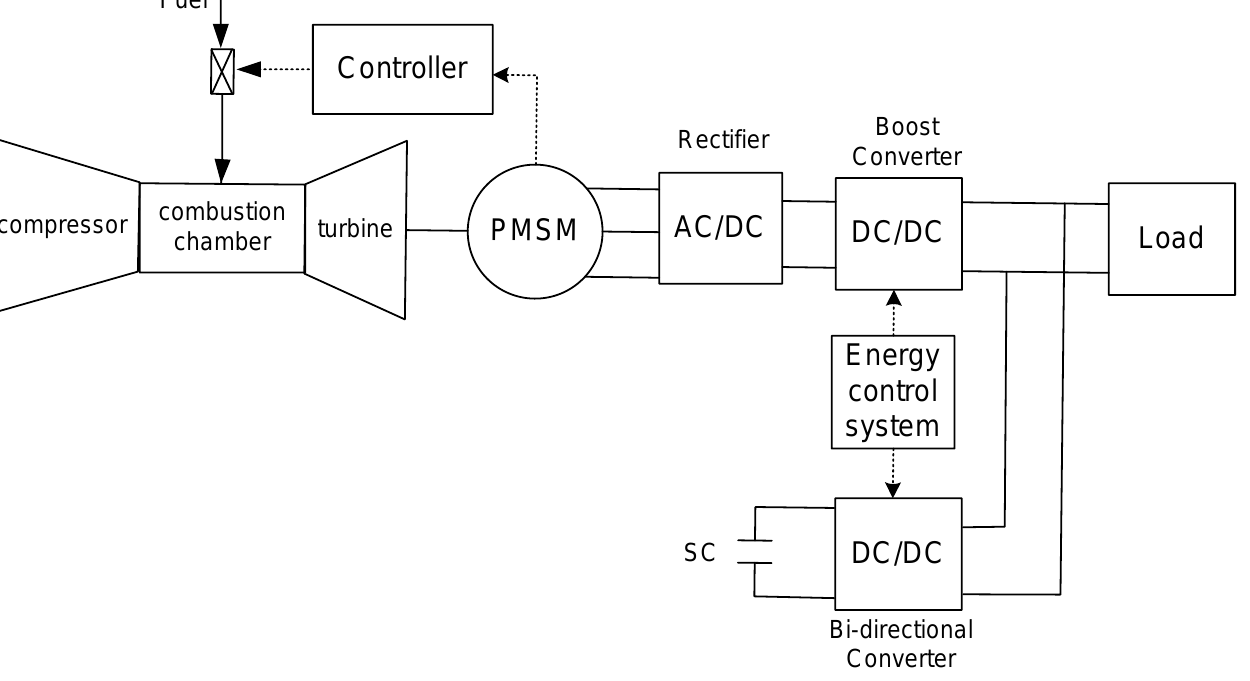
Figure 1. A block diagram of a charging station based on MGT and a supercapacitor.